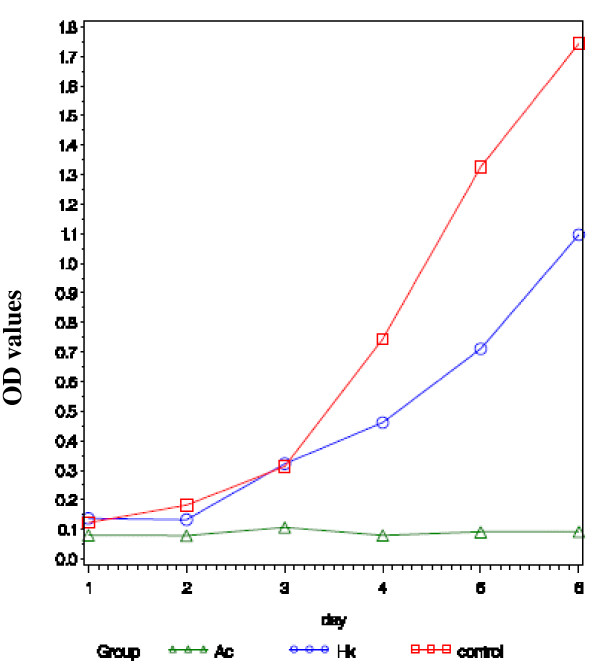
displays the growth curve according to the values of 490 nm wavelength light absorption in the three groups. In the third to sixth day, significant difference as exhibited in cell growth inhibition in Ad-A1+A2+C1+C2 group. But there is a slight difference between the control cell and the cells infected with Ad-HK.